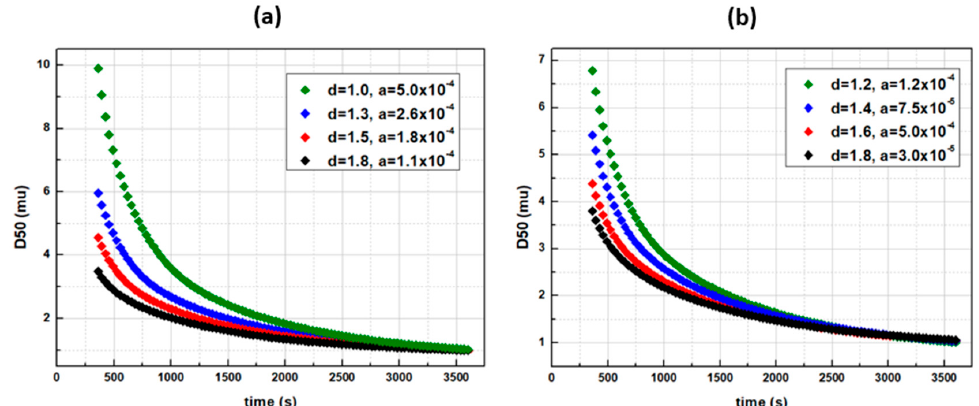
Figure 7. Austin’s breakage function for a D50 = 1 μ m final size via various time profile paths with ( a ) γ = 1.17 and φ = 0.3 and ( b ) with γ = 1.25 and φ = 1 (de Vegt approximation).